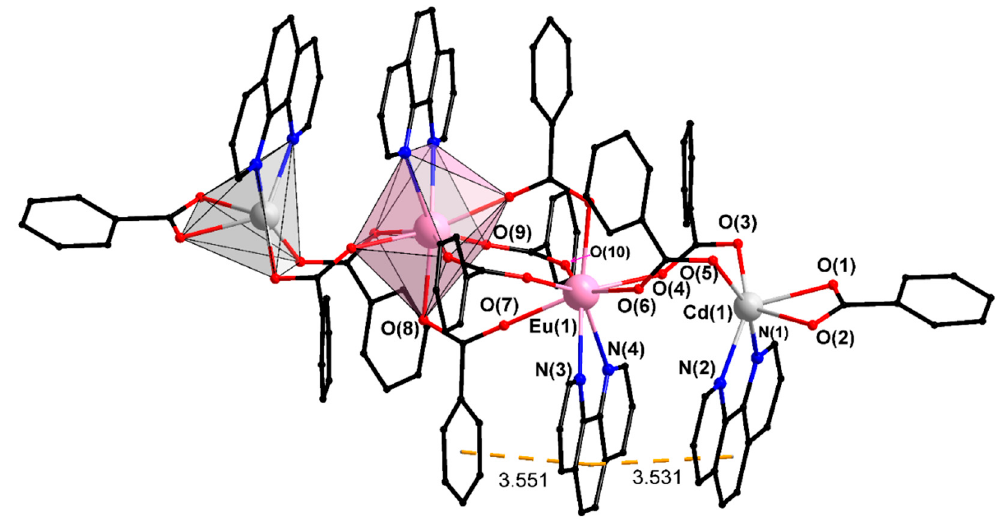
Figure 4. Structure of complex X. Hydrogen and fluorine atoms as well as solvate molecules are omitted.